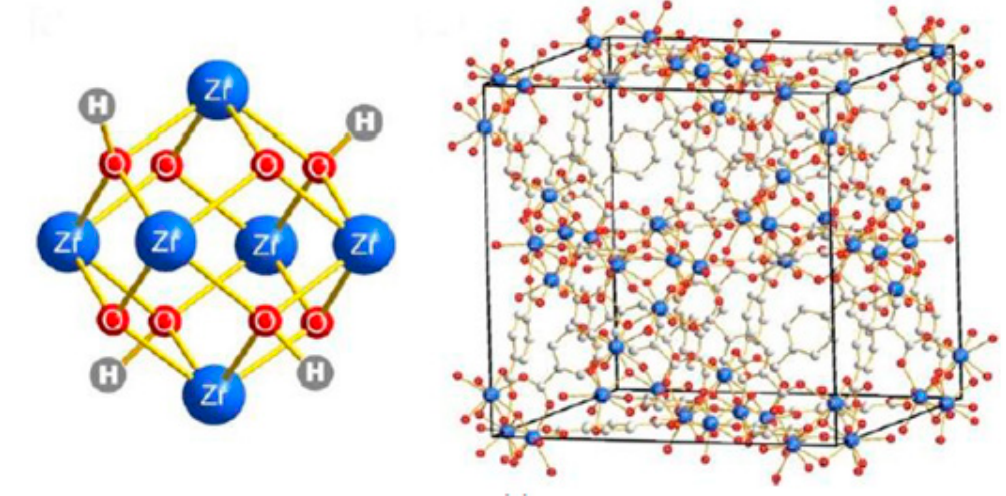
Figure 11. University of Oslo (UiO)-66 structure [ 118].